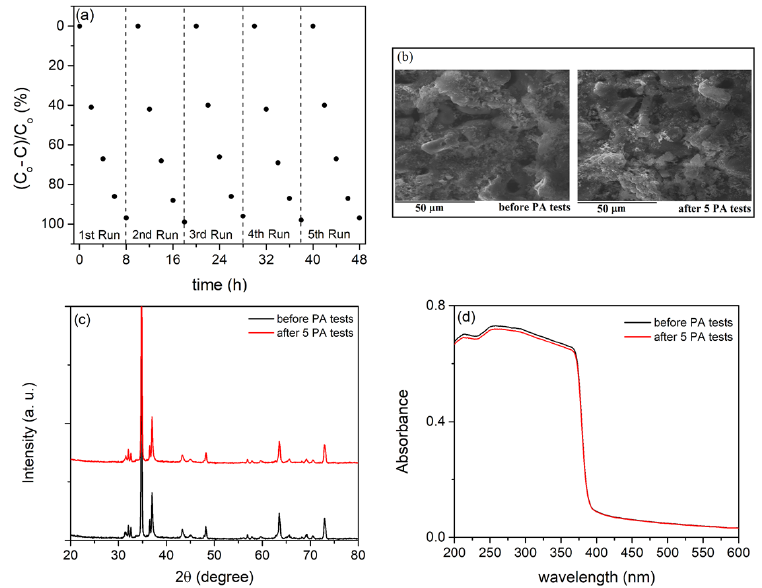
Figure 9. ( a ) Recycling test of MO photodegradation; ( b ) SEM micrographs before and after 5 cycles; ( c ) XRD patterns before and after 5 cycles; ( d ) XRD patterns before and after 5 cycles for coating formed in aluminate electrolyte + 12 g/L ZnO.